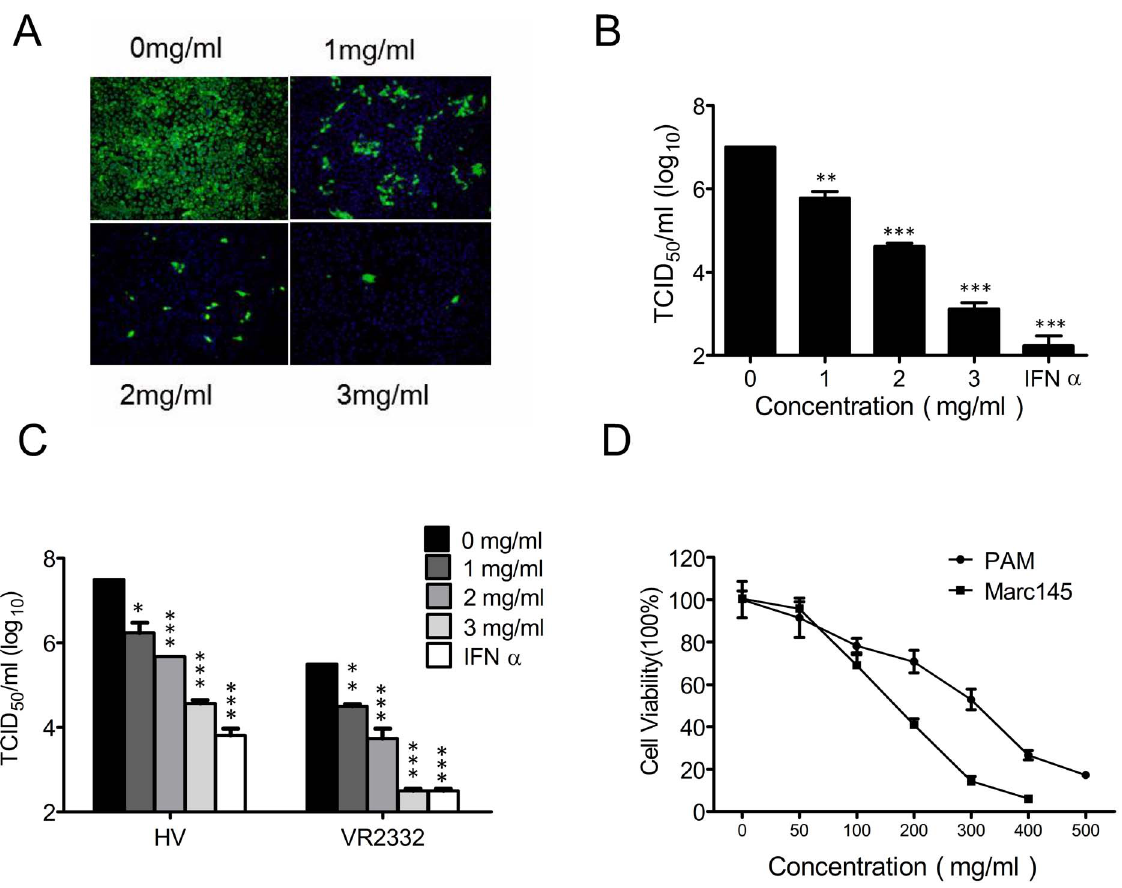
Figure 1. Cryptoporusvolvatus extract inhibits PRRSV replication. (A and B) The Cryptoporus volvatus extract blocks PRRSV Ch1a replication in Marc-145 cells. Marc-145 cells were infected with PRRSV Ch1a at an MOI of 0.1, and then treated with IFN- a (10 units/ m l) or the Cryptoporus volvatus extract at various concentrations. At 24 h p.i., cells were fixed and analyzed by IFA using antibody against PRRSV N protein (A), and virus yield in the supernatants was also quantified (B). Cultures treated with normal saline were set up as control (0 mg/ml). Results are from three independent experiments, each of which was in triplicate. (C) Cryptoporus volvatus extract potently inhibits both PRRSV VR2332 and HV replication in PAMs. A similar virus inhibition assay was performed with PAM cells infected with PRRSV strain VR2332 or HV at an MOI of 0.1 in the presence of IFN- a (10 units/ m l) or the Cryptoporus volvatus extract at various concentrations. (D) Determination of cytotoxicity of the Cryptoporus volvatus extract by MTT assay. PAMs or Marc145 cells were incubated with various concentrations of the Cryptoporus volvatus extract or the control normal saline for 48 h prior to the MTT assay. Data are representative of three independent experiments (mean 6 SD). Statistical significance was analyzed by Student’s t test . * P , 0.05 ; ** P , 0.01 ; *** P , 0.001